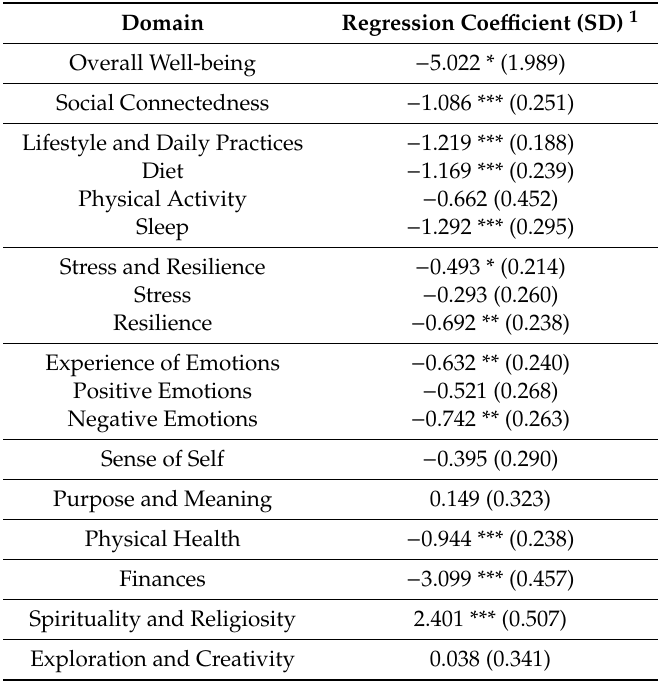
Table 3. Regression coe ffi cients for being unhoused when predicting overall well-being score and the scores of the 10 constituent domains of